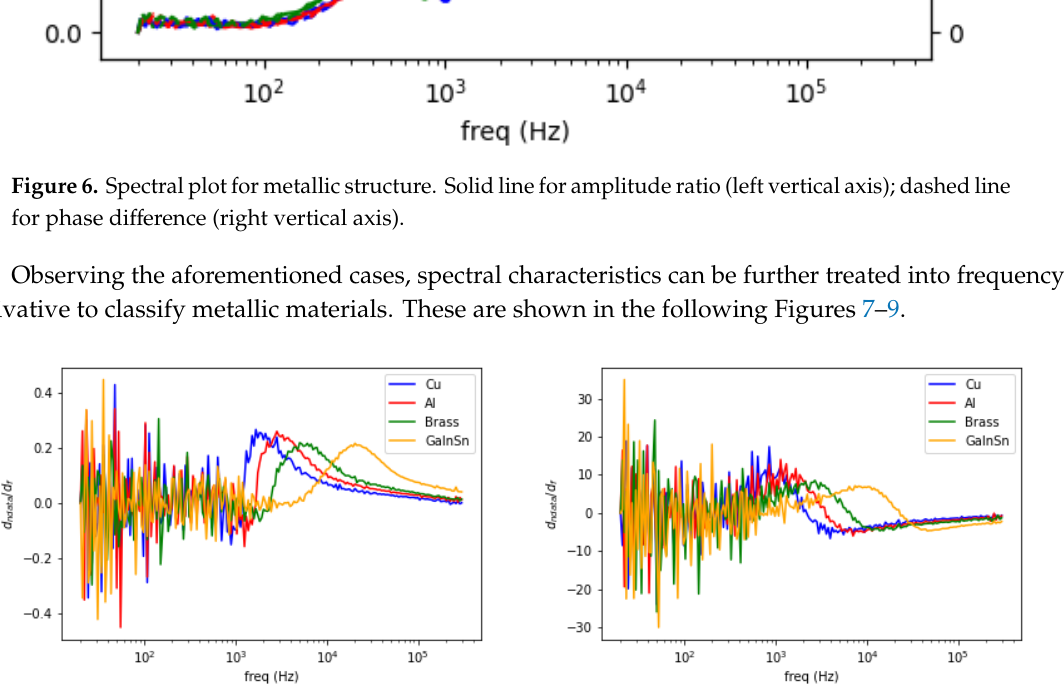
Figure 7. Spectral derivative for metallic samples with conductivity variations ( left : amplitude, right : phase).